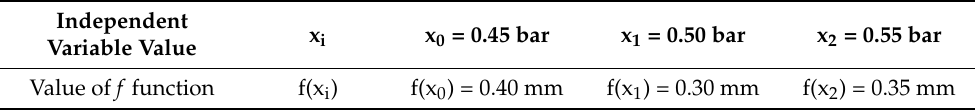
Table 5. Interpolation points and value of the function